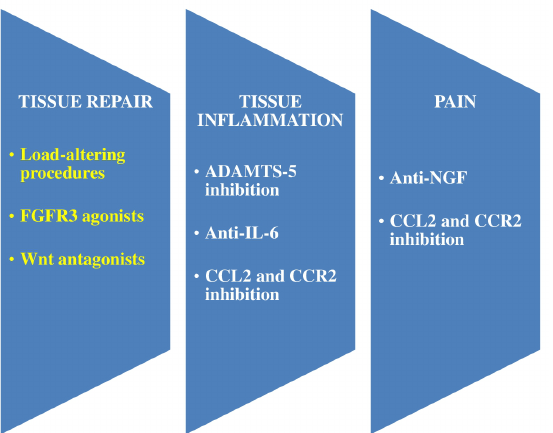
Figure 4. Main emergent therapeutic objectives in osteoarthritis (OA) are shown. Pathological objectives mainly gather into those facilitating repair, those neutralizing pain, and those preventing tissue inflammation (resulting in turn in degeneration). There is a mutual correlation between inflammatory and repair processes in the OA articulation, both of which impact pain. Objectives that demonstrate effectiveness in murine experiments and for which therapeutic approaches are being studied in clinical trials are shown. White color indicates promotion, and yellow color represents suppression. Peripheral pain emerges from joint pathology and may prevent tissue swelling and facilitate tissue repair by suppressing mechanical overload of the articulation. FGFR = fibroblast growth factor receptor. IL = interleukin. ADAMTS = a disintegrin and metalloproteinase with thrombospondin motif. CCL = C-C motif chemokine. CCR = C-C chemokine receptor. NGF = nerve growth factor.